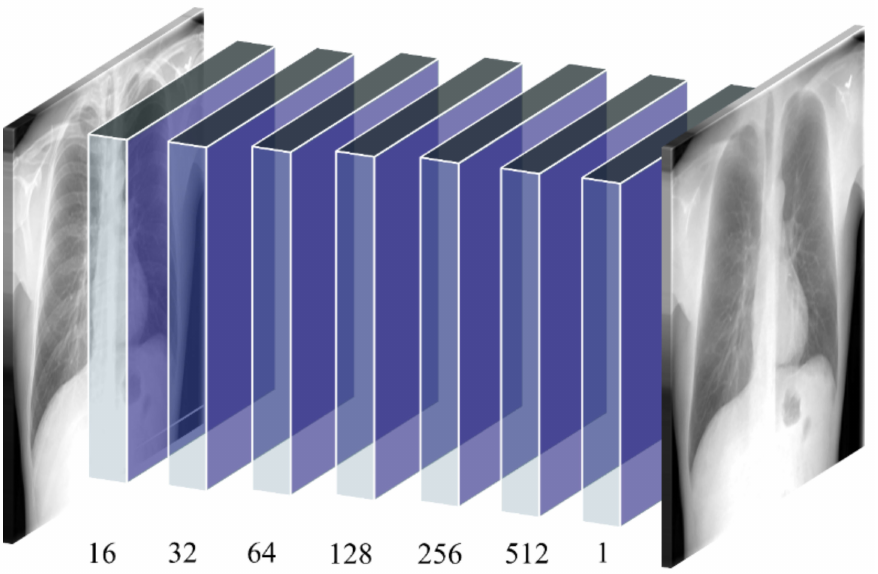
Figure 2. The architecture of the proposed ConvNet–BS model. The ConvNet–BS model has seven convolutional layers (shown with blue-colored boxes) with zero paddings to preserve original input dimensions. The deepest convolutional layer with the sigmoidal activation produces bone-suppressed soft-tissue images.